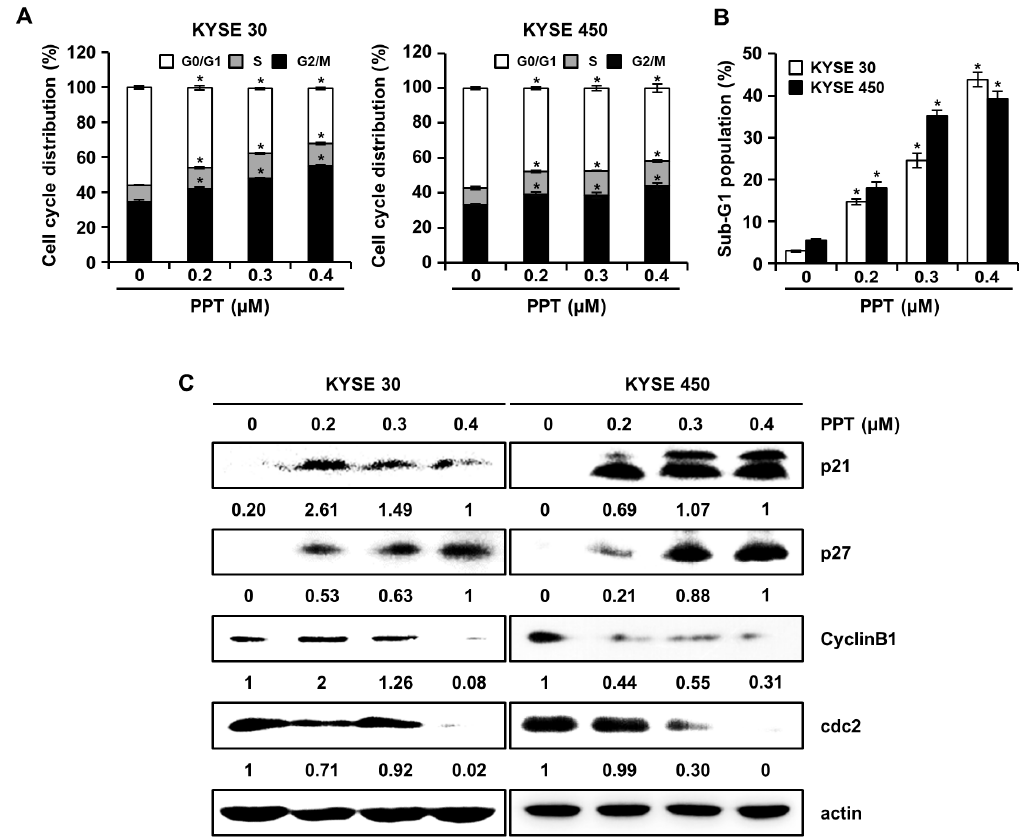
Figure 2. PPT causes cell cycle arrest at the G2 / M phase in ESCC cells. KYSE 30 and KYSE 450 cells were treated with vehicle or 0.2, 0.3, and 0.4 µ M PPT for 48 h. ( A ) The cells were stained with propidium iodide (PI) and cell cycle distribution was analyzed by a Muse ™ Cell Analyzer (Merck Millipore, Darmstadt, Germany). Data present the mean ± SD of triplicate independent experiments; * p < 0.05, compared to the control cells. (B) The percentage of cells in the sub-G1 phase in the KYSE 30 and KYSE 450 cells is graphed. Each experiment was performed three times. The values are graphed as the means ± SD of three independent experiments for each treatment (* p < 0.05 compared to untreated controls). ( C ) The expression of p21, p27, cyclin B1, and cdc2 protein in DMSO or PPT-treated ESCC cells was analyzed by Western blots. Actin was used as a loading control.